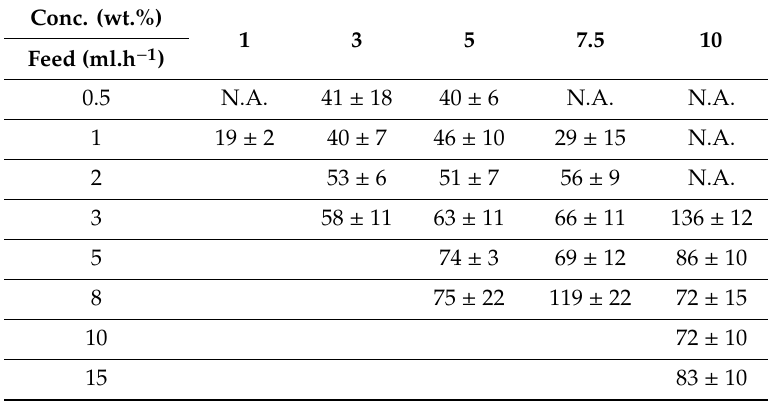
Table 2. Average diameter of fiber ( μ m).